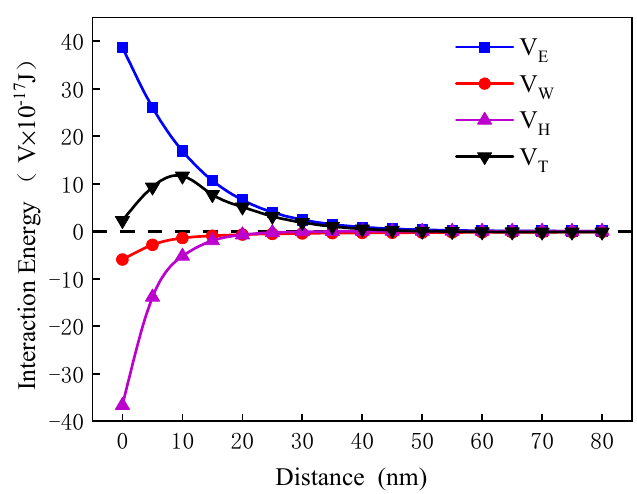
Figure 9. The extended-Derjaguin-Landau-Verwey-Overbeek (extended-DLVO) interaction energy between fine pyrite particles in aqueous solution.